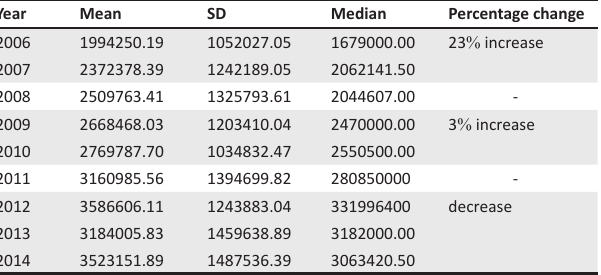
FIG URE 2: Total remuneration (2006–2014).